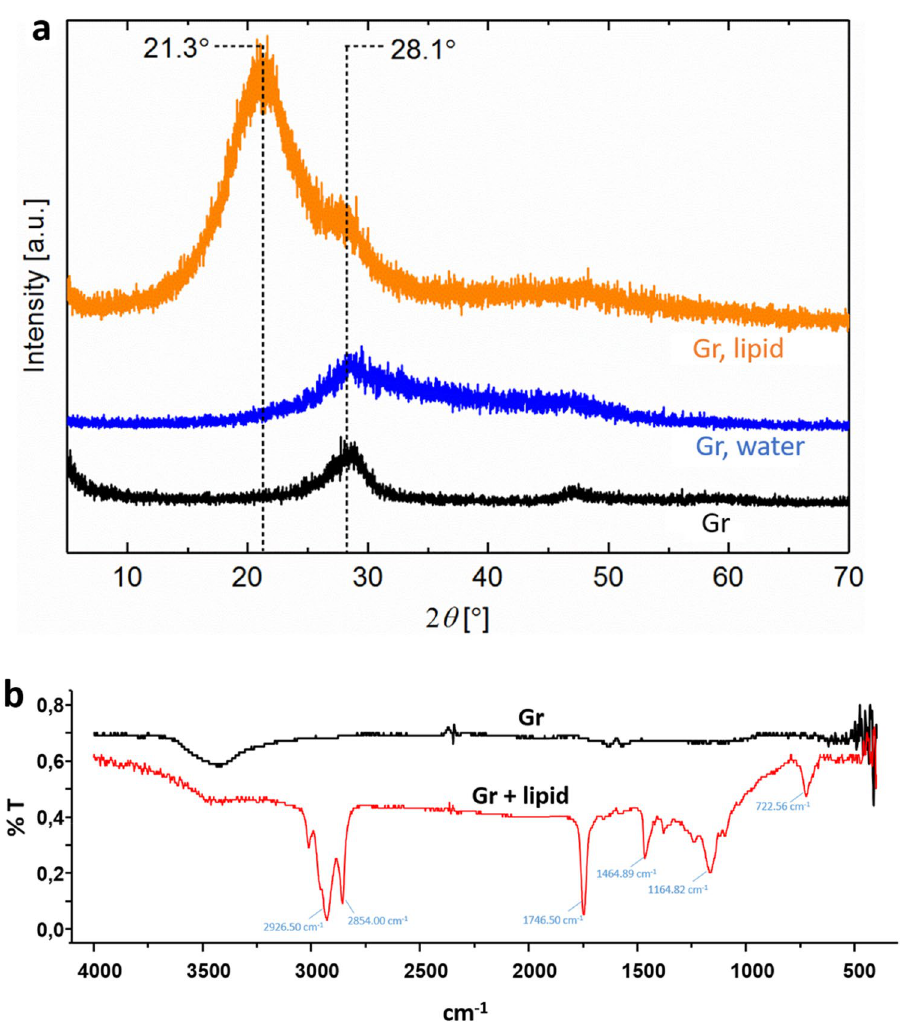
Figure 2. ( a ) X-ray diffractograms of graphene flakes alone (Gr), graphene flakes soaked in Milli-Q water (Gr + water) and graphene flakes soaked in lipids (Gr + lipid). ( b ) FTIR spectra of graphene flakes alone (Gr) and graphene flakes soaked in lipids (Gr +